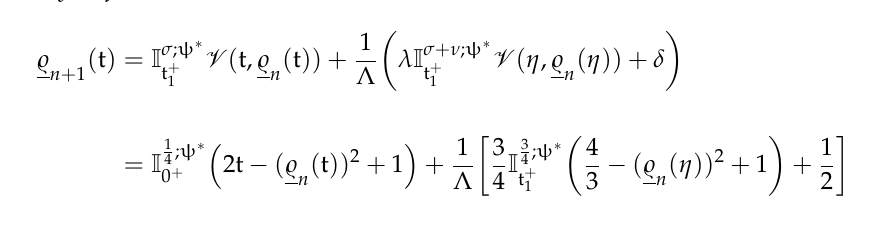
for ψ ∗ ( t ) = t,2 t , n